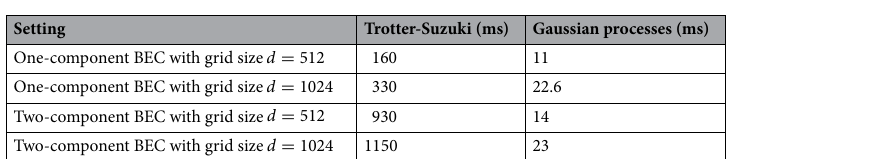
Table 2. Trotter-Suzuki vs Gaussian